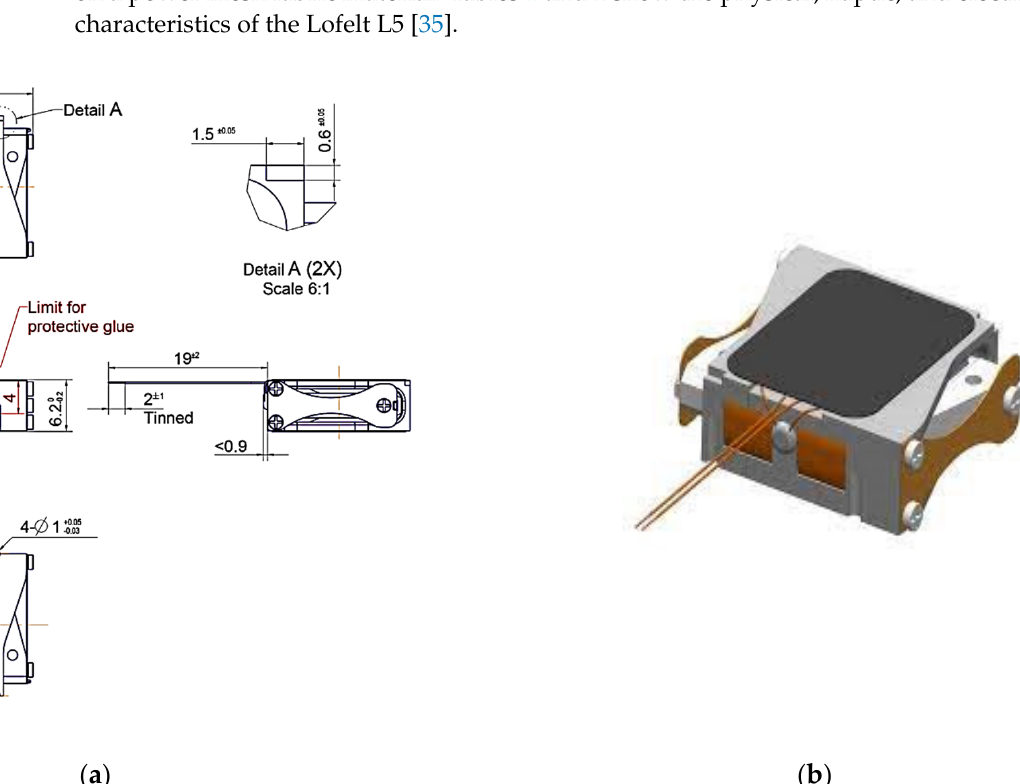
Figure 1. ( a ) Technical and dimensional information for the L5 voice coil actuator, and ( b ) the voice coil actuator (Model: Lofelt L5) used in this study [35]. Table 1. Physical Characteristics of Lofelt L5